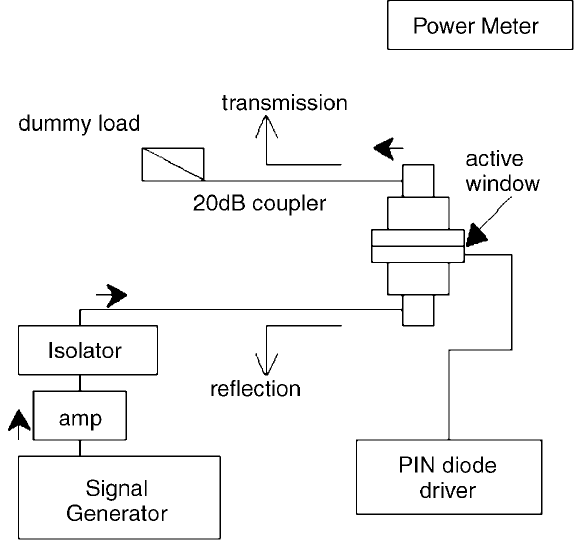
FIG. 15. (Color) Typical waveform of reflection with various forward biases.